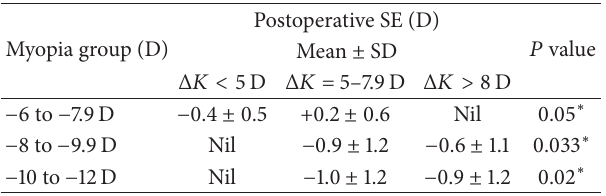
Table 4: Postoperative spherical equivalence stratified by change in